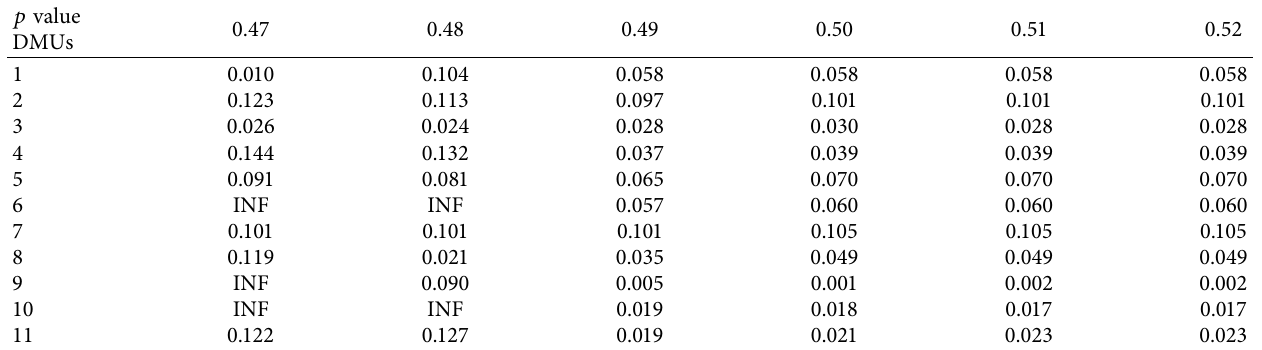
Table 7: The results of solving model (13).